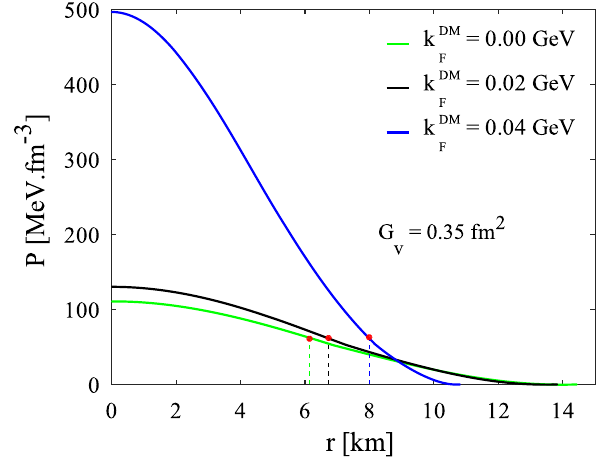
Fig. 3 Pressure as a function of the radial coordinate of a star with 2 M (cid:9) for different contributions of dark matter. The red dots mark the radial coordinate point where occurs the phase transition between quark and hadronic phases